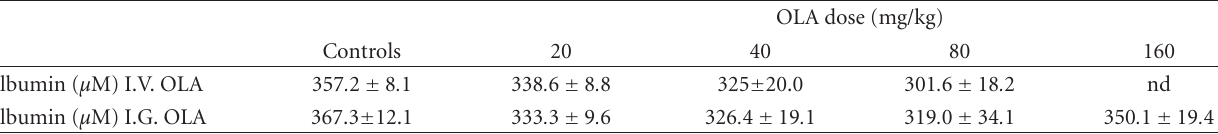
Table 1: Plasma albumin concentrations 24h after intravenous (I.V.) and intragastric (I.G.) OLA administration.